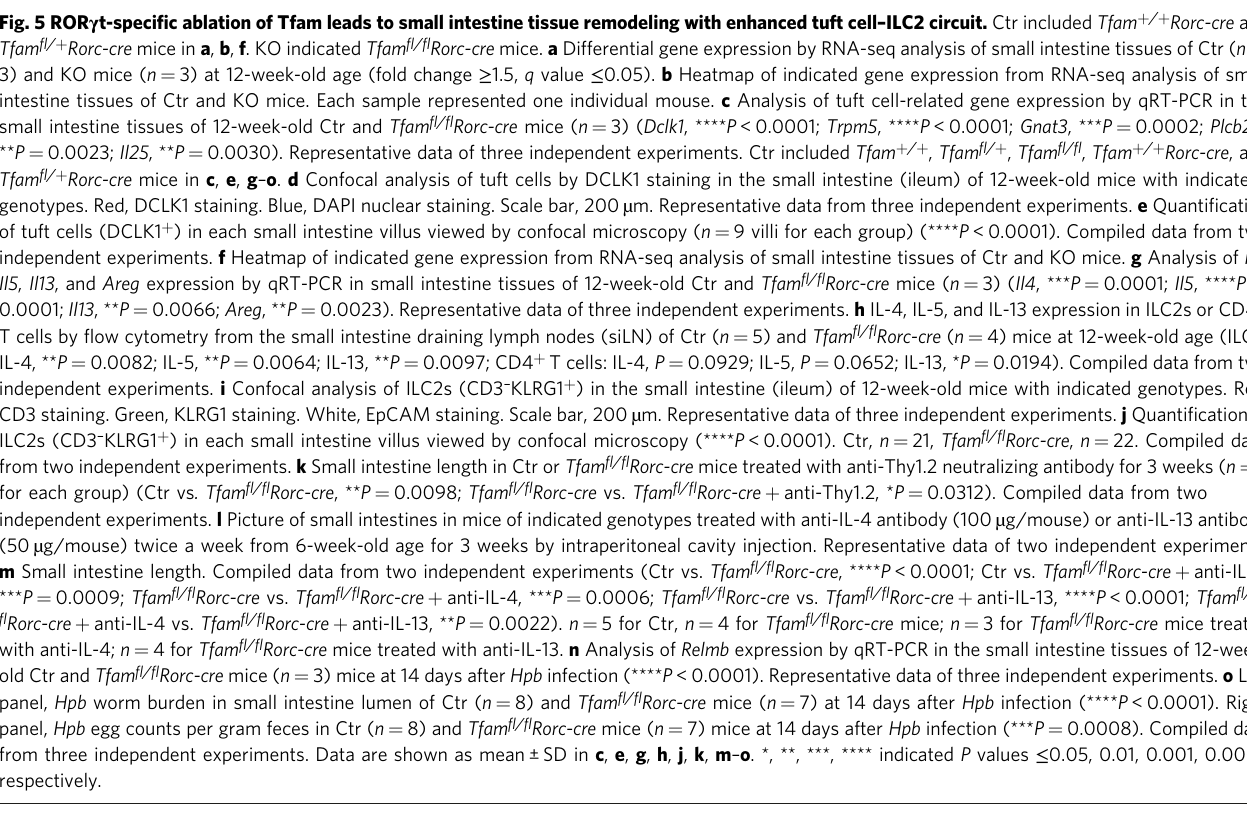
Fig. 5 ROR γ t-speci fi c ablation of Tfam leads to small intestine tissue remodeling with enhanced tuft cell – ILC2 circuit. Ctr included Tfam + / + Rorc-cre and Tfam fl / + Rorc-cre mice in a , b , f . KO indicated Tfam fl / fl Rorc-cre mice. a Differential gene expression by RNA-seq analysis of small intestine tissues of Ctr ( n = 3) and KO mice ( n = 3) at 12-week-old age (fold change ≥ 1.5, q value ≤ 0.05). b Heatmap of indicated gene expression from RNA-seq analysis of small intestine tissues of Ctr and KO mice. Each sample represented one individual mouse. c Analysis of tuft cell-related gene expression by qRT-PCR in the small intestine tissues of 12-week-old Ctr and Tfam fl / fl Rorc-cre mice ( n = 3) ( Dclk1 , **** P < 0.0001; Trpm5 , **** P < 0.0001; Gnat3 , *** P = 0.0002; Plcb2 , ** P = 0.0023; Il25 , ** P = 0.0030). Representative data of three independent experiments. Ctr included Tfam + / + , Tfam fl / + , Tfam fl / fl , Tfam + / + Rorc-cre ,